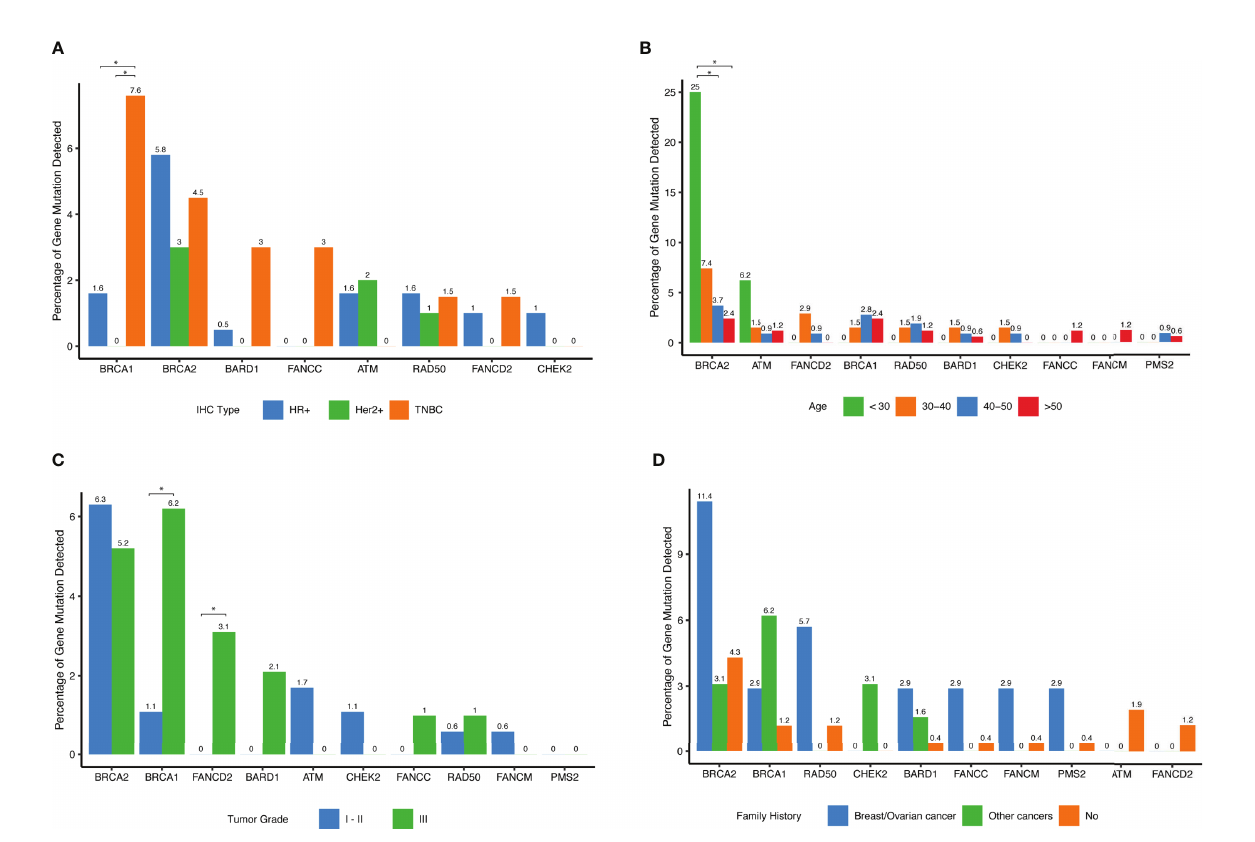
FIGURE 4 | Distribution of deleterious mutations among different clinical subgroups for the selected genes. (A) Percent of deleterious variants detected in different IHC subtypes for a given gene. The top 10 most frequent mutated genes are shown. (B) Percent of deleterious variants detected in different age groups for a given gene. The top 10 most frequent mutated genes are shown. (C) Percent of deleterious variants detected in different tumor grade groups for each of the top 10 mutated genes. (D) Percent of deleterious variants detected in different family history groups for a given gene. The top 10 most frequent mutated genes are